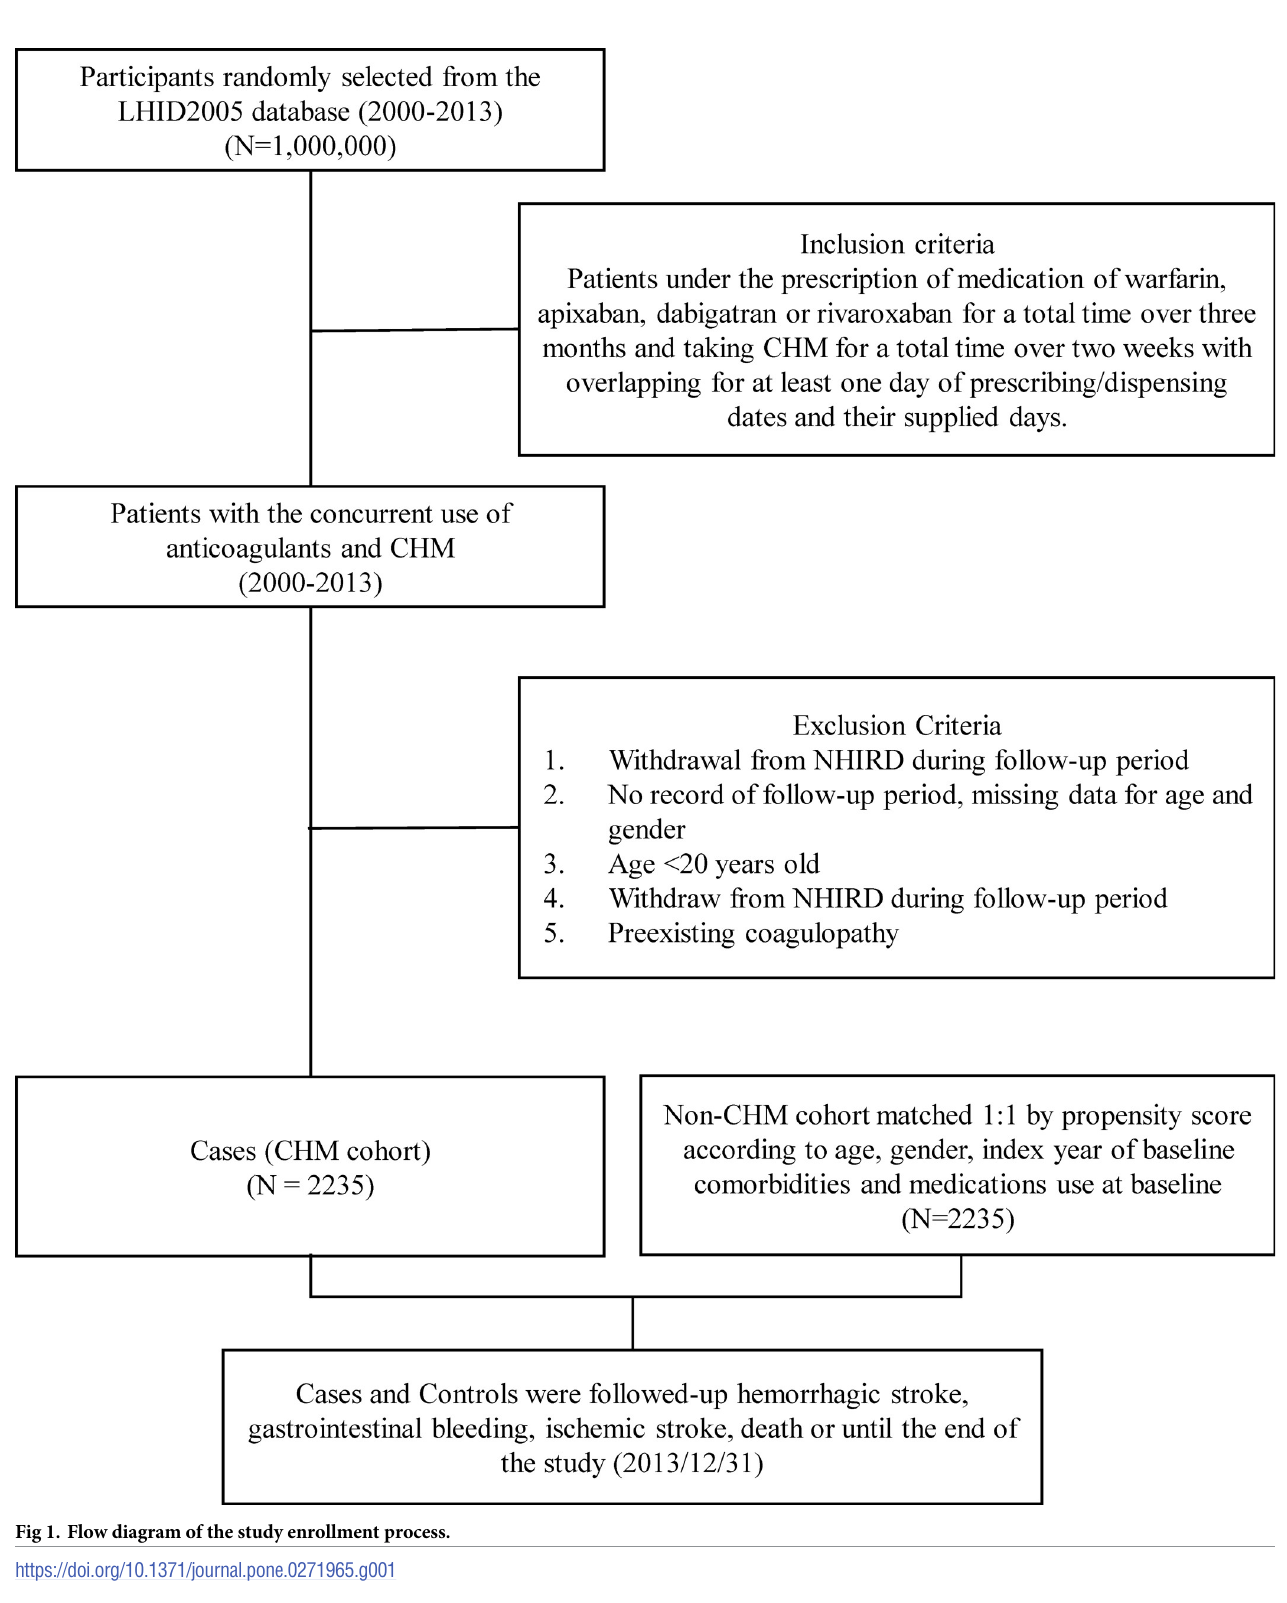
Fig 1. Flow diagram of the study enrollment process.